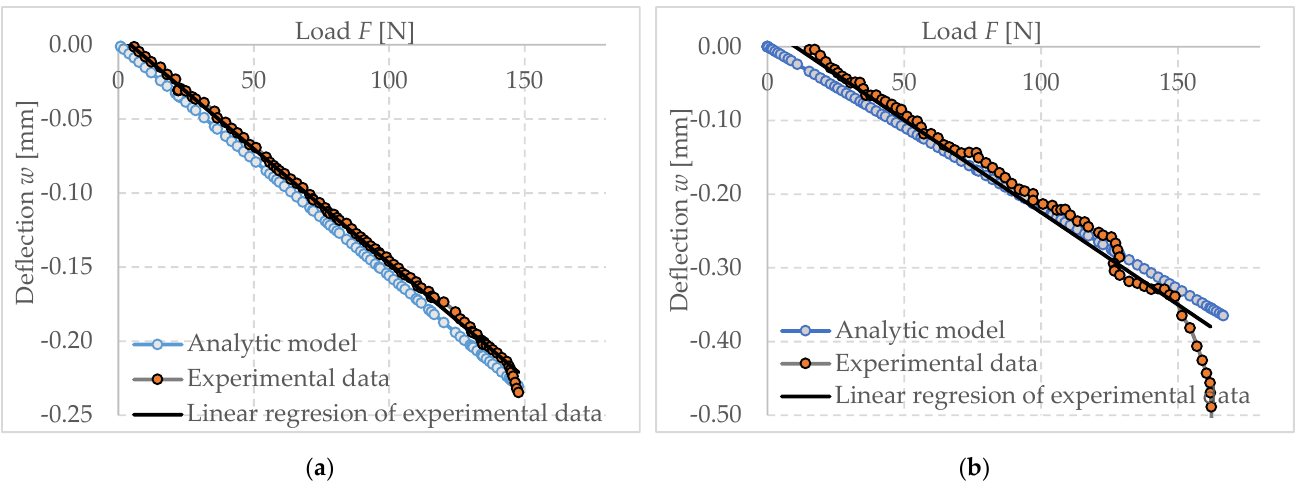
Figure 12. Dependence of deflection (cantilever end) on force (load of the cantilever end) investigated CC specimen 5200420, ( a ) with used calibration of measuring system ( b ) not corrected data .